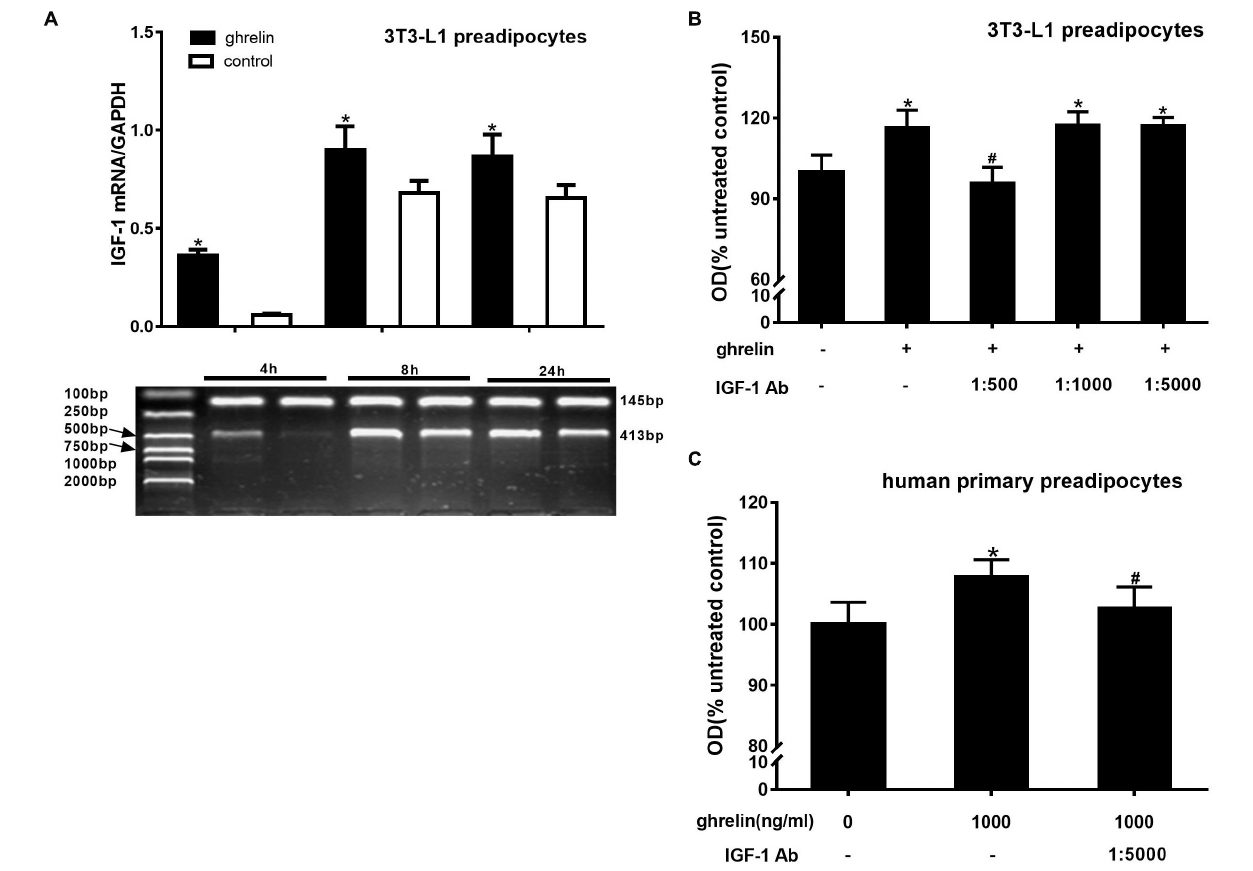
FIGURE 3 | Ghrelin upregulated the expression of IGF-1 in 3T3-L1 and human preadipocytes. Effects of ghrelin on IGF-1 mRNA levels in 3T3-L1 preadipocytes (A) . Effect of IGF-1 antibody on the proliferation of 3T3-L1 preadipocytes (B) and human primary preadipocytes (C) . The data are presented as the mean ± SD for three independent experiments with eight individual wells in each experiment. ∗ p < 0.05 vs. 0 ng/ml ghrelin group, # p < 0.05 vs. ghrelin